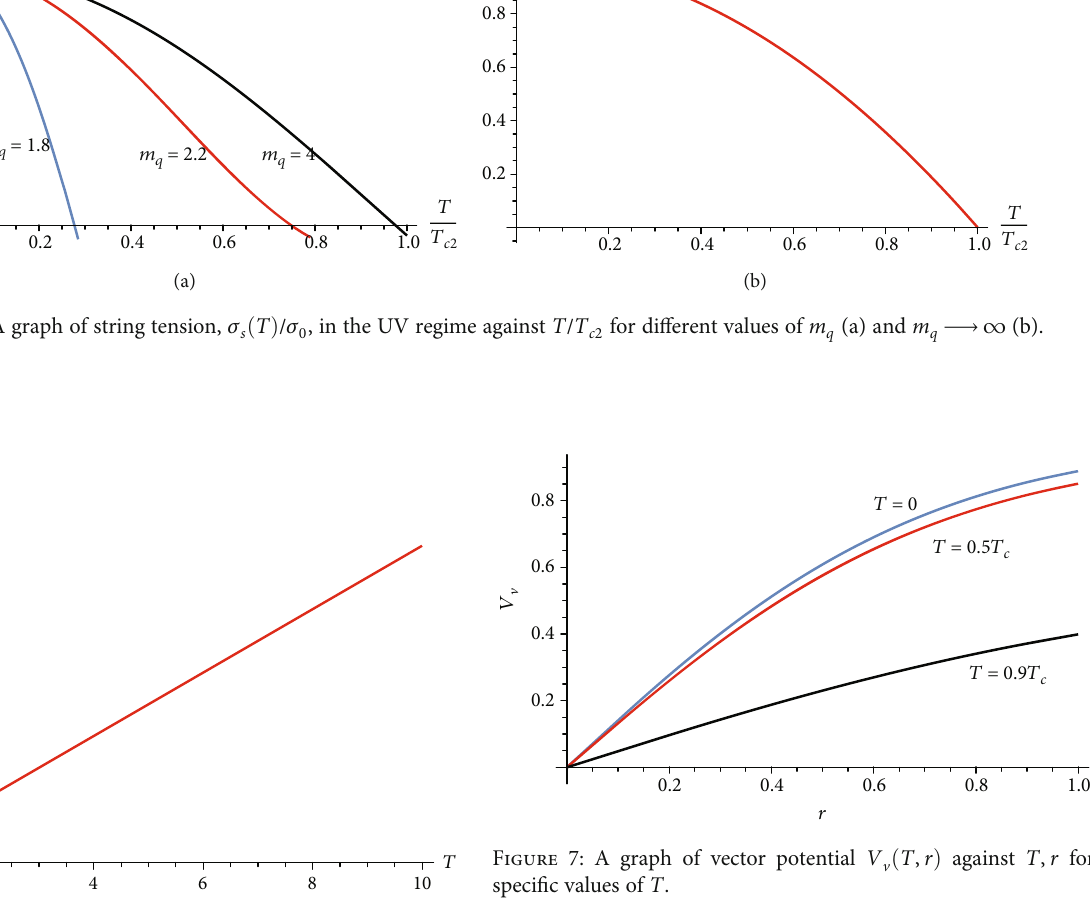
ð T , r Þ against T , r for v